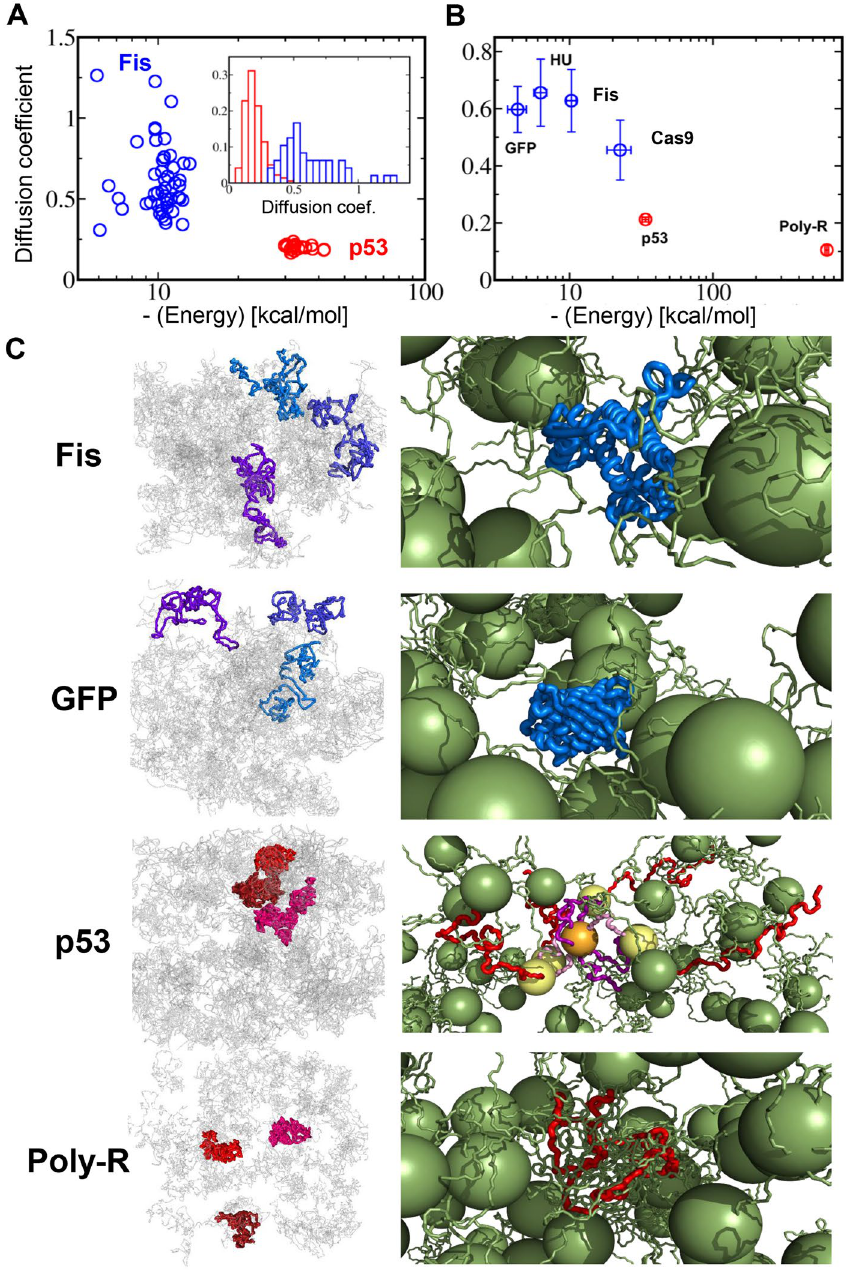
Figure 6. Molecular dynamic (MD) simulations demonstrate different diffusion properties for folded proteins and intrinsically disordered proteins (IDPs) within p53 tetramer condensate. ( A ) Diffusion coefficient plots of guest proteins (Fis and p53) within p53 condensate as a function of the intermolecular energy of these guest proteins with the neighboring p53 tetramers. The inset shows the distribution of the calculated D values for Fis and p53. ( B ) Similar plot as in panel ( A ) for four folded proteins (blue) and two IDPs (red). The errors denote the standard deviation reflecting the heterogeneity in the energy and D value. ( C ) Projections of three independent trajectories (in reddish or bluish colors) of diffusion for two folded guest proteins (Fis and GFP) and two IDPs (p53 and poly-R) within p53 condensate, illustrating greater restricted diffusion of the IDPs compared with the folded proteins (left panels). Gray lines represent the location of the center of mass of the 20 tetrameric p53 that comprise its liquid-like condensate during the simulations. Snapshot of the guest proteins in p53 condensate illustrate the extensive interactions of the IDPs with p53 via intermolecular interactions between their disordered regions (right panels). The folded proteins can be trapped in voids and interact less tightly with the p53 condensate. The host p53 tetramer are shown in green, with the core and Tet domains as large spheres. The guest folded proteins and IDP are shown in blue and red, respectively. For the guest p53, the core and Tet domains, respectively, are shown in yellow and orange, and the N- and C-terminal disordered domains and linker are shown in red, purple, and pink,